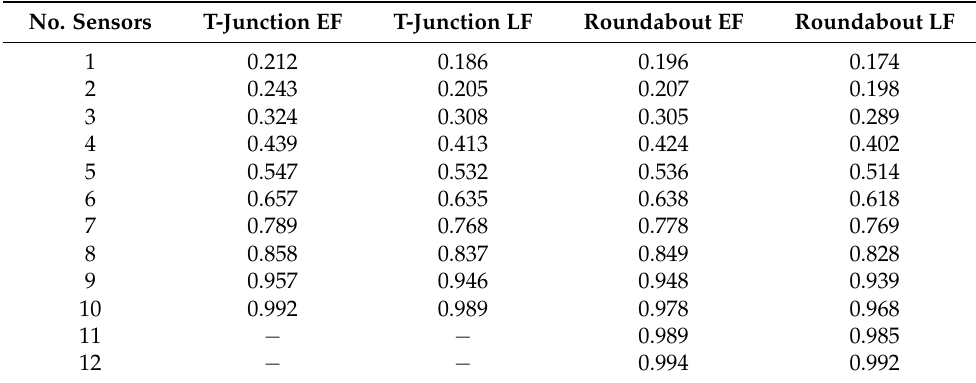
Table 3. Comparative performance analysis considering various numbers of the active